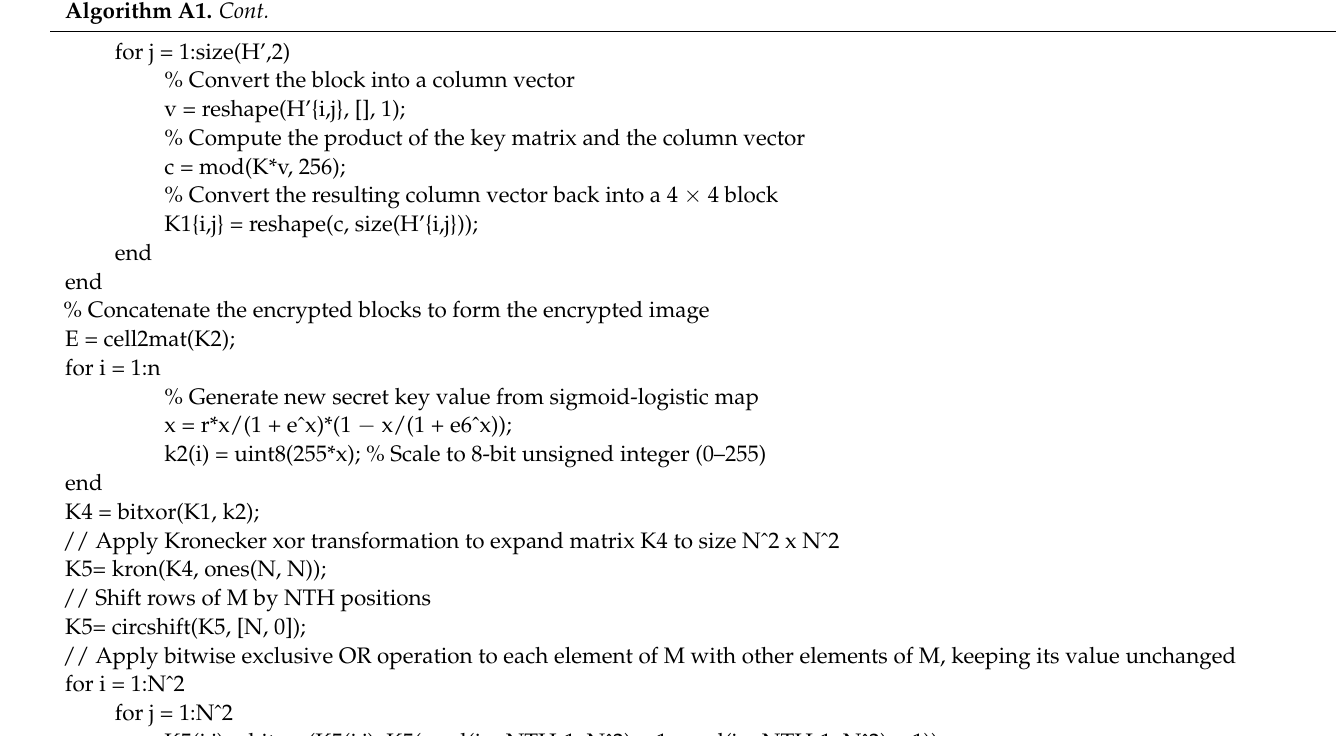
Algorithm A1. Cont.